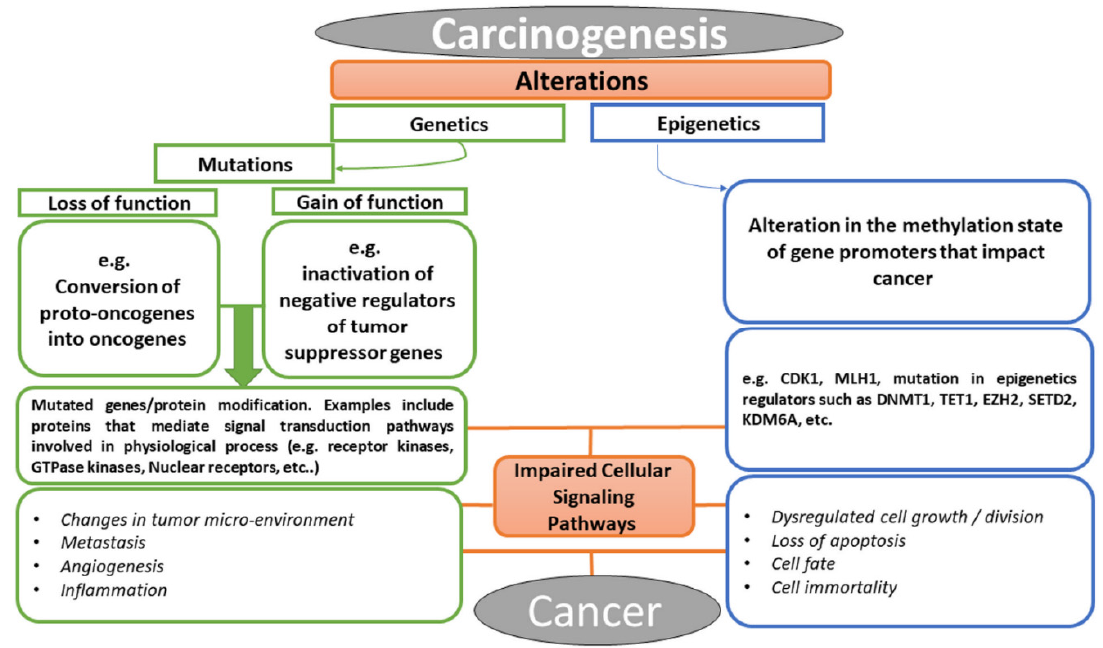
Figure 2. Chronological events that lead to cancer, explaining the relationship between abnormal cellular signaling pathway and cancer formation.